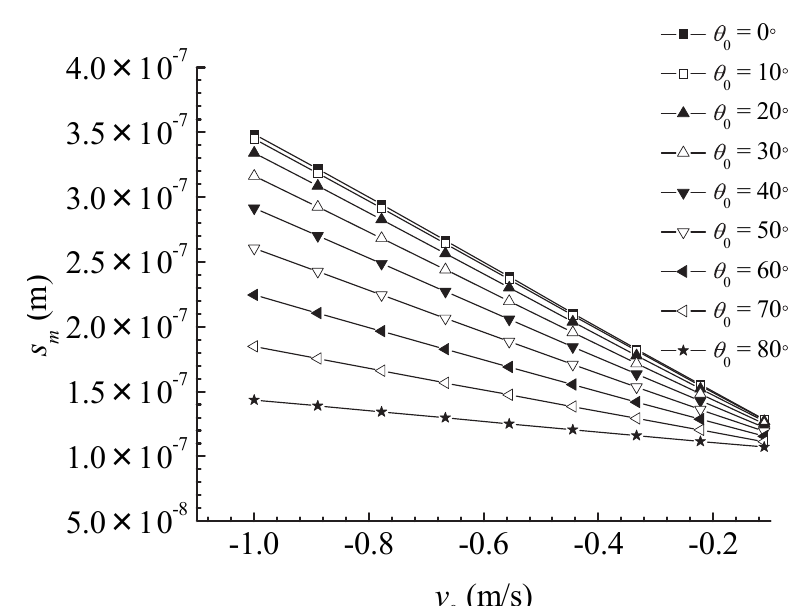
and v at the stage of m 0